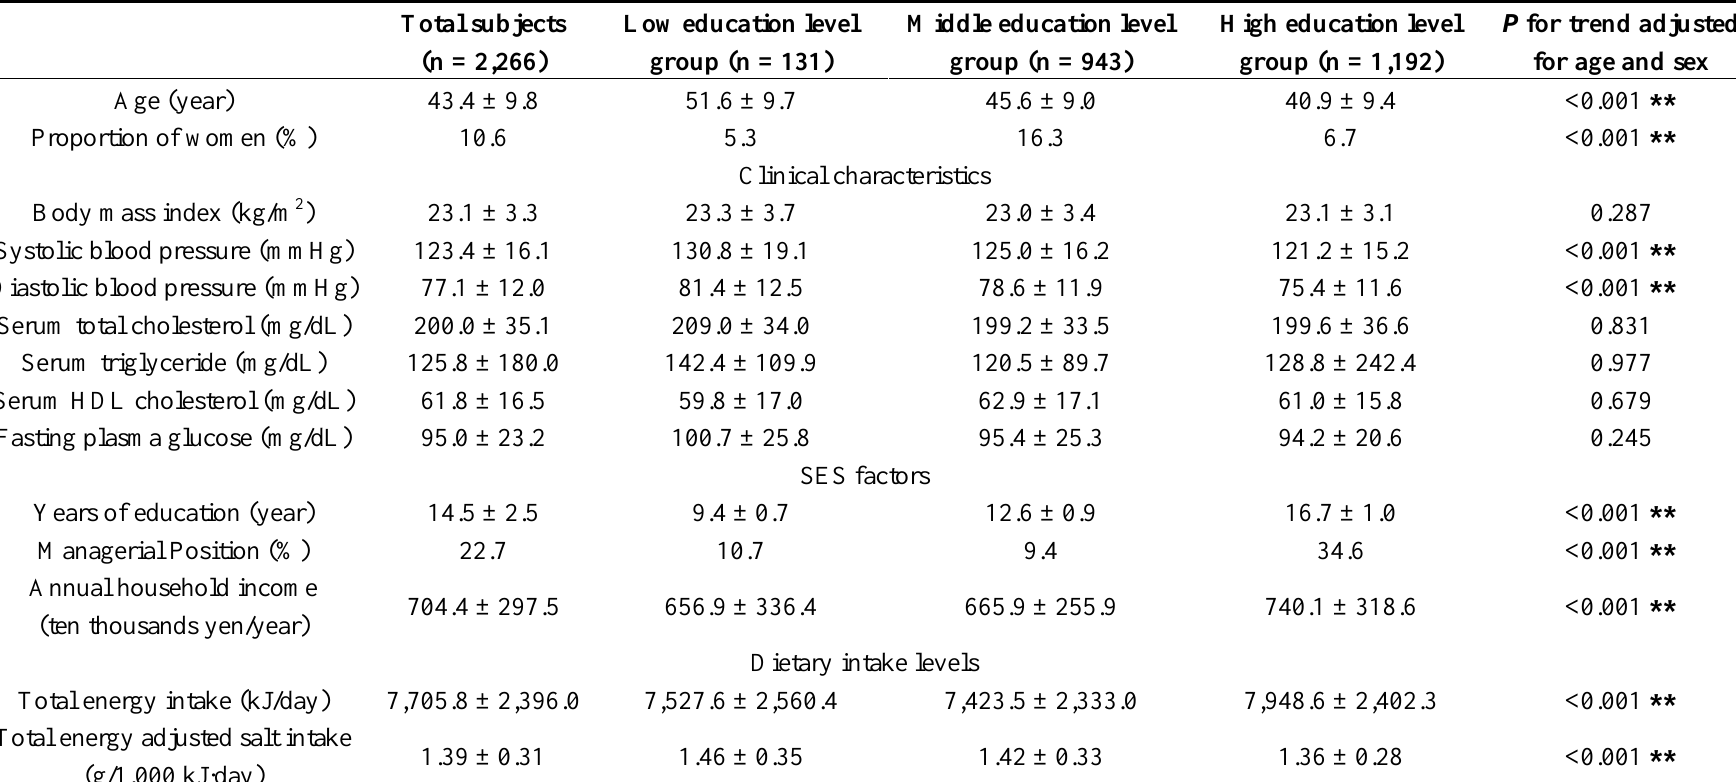
Table 1. Clinical characteristics, dietary nutrients intake data, and socioeconomical status factors of the study subjects according to different education level